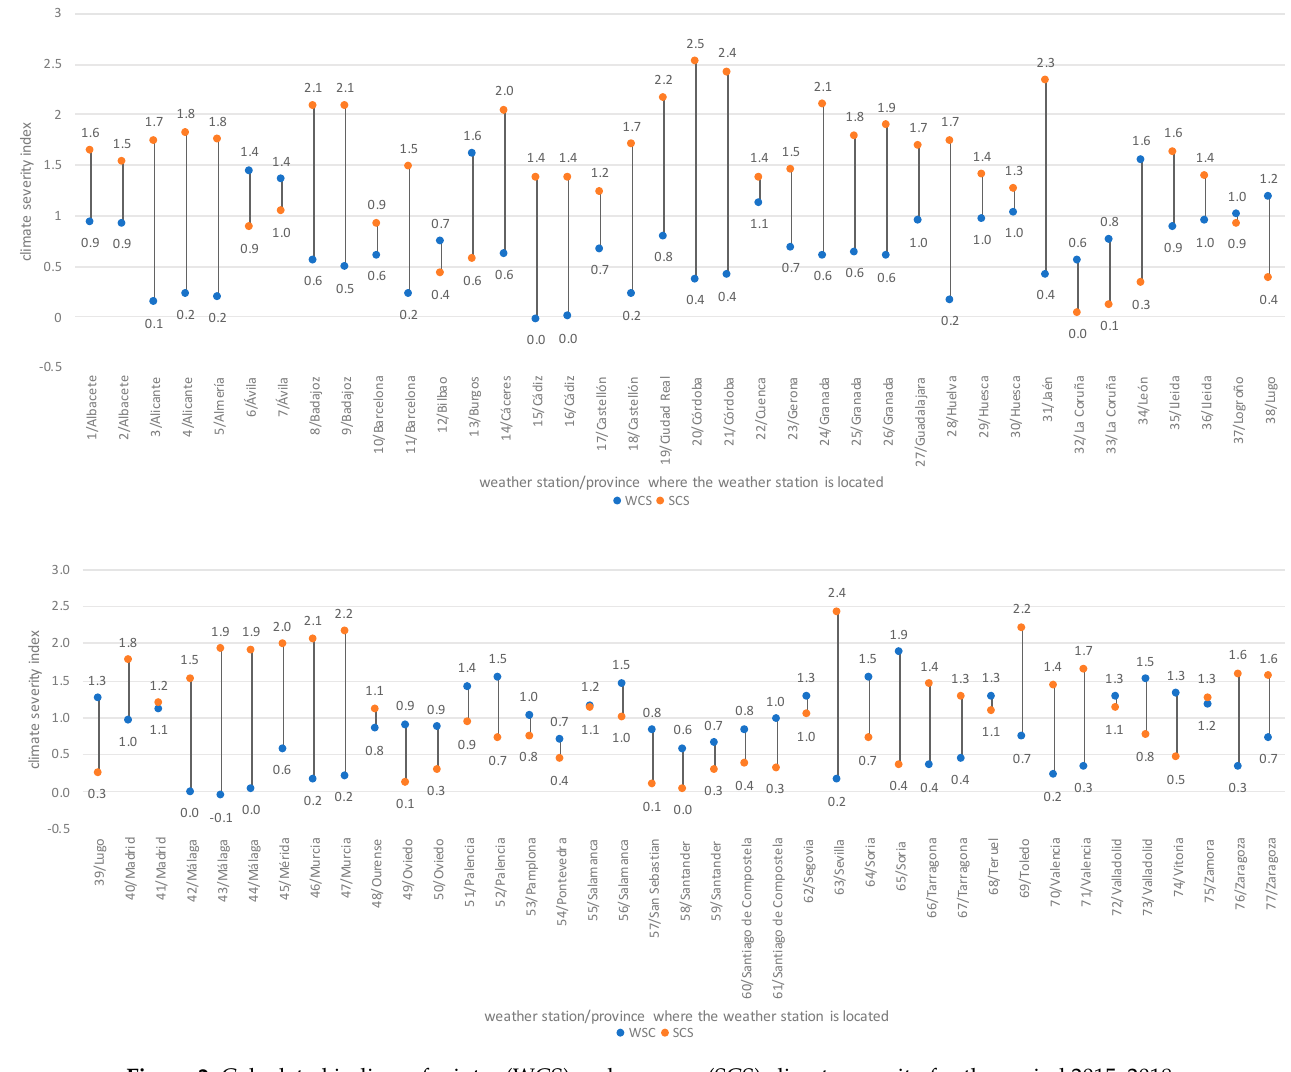
Figure 2. Calculated indices of winter (WCS) and summer (SCS) climate severity for the period 2015–2018. In the case of the SCS, values reaching the minimum in the coastal province of La Coruña (station #32), with 0.04, and the maximum in the inland province of Cordoba (sta- tion #20), with 2.52, are observed. The lowest SCS values occur in regions with cool sum- mer temperatures; this is the case of stations #32, #33, #60, and #61 located in La Coruña, #34 in León, #49 and #50 in Asturias, #57 in Guipúzcoa, #58 and #59 in Cantabria, among others, all of them in the north of the peninsula and with SCS values below 0.4. In these regions, with a good design of the building’s constructive solutions, the indoor comfort temperature can be reached without implementing active cooling systems. However, the higher the SCS value, the higher the summer temperatures in these regions, which leads to higher cooling energy demands. It is the case of stations located in the peninsula’s in- terior, with SCS values higher than 2, such as #8 and #9 in Badajoz, #14 in Cáceres, #19 Ciudad Real, or #20 and #21 in Córdoba, among others. The stations located in the inland provinces of Madrid (#40, #41), Salamanca (#55, #56), or Segovia (#62) stand out, with WCS and SCS values higher than 1. These conditions are found in places with a Mediterranean climate far from the sea, with long and cold winters, with temperatures that can drop below 0 °C, with numerous frosts occurring at night. In contrast, summers are pretty hot and dry, with a temperature range of 18.5 °C, and temperatures often exceed 30 °C. In these regions, the energy demand is considerably